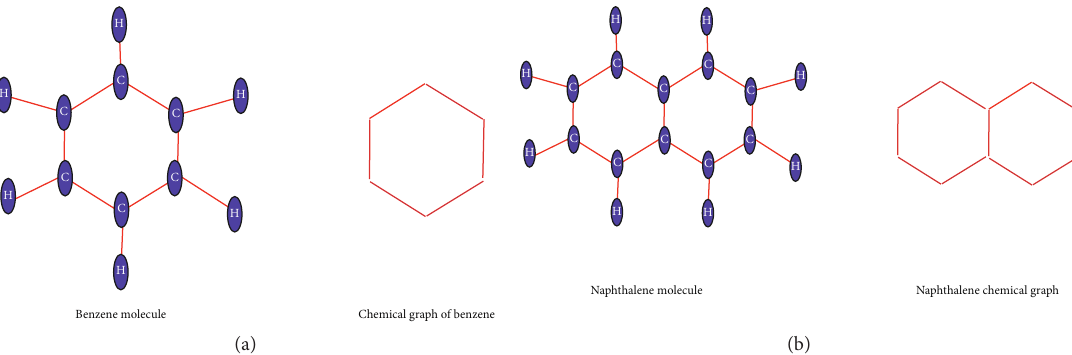
Figure 1: Some hydrocarbons with associated chemical graphs. (a) Benzene with chemical graph. (b) Naphthalene with chemical